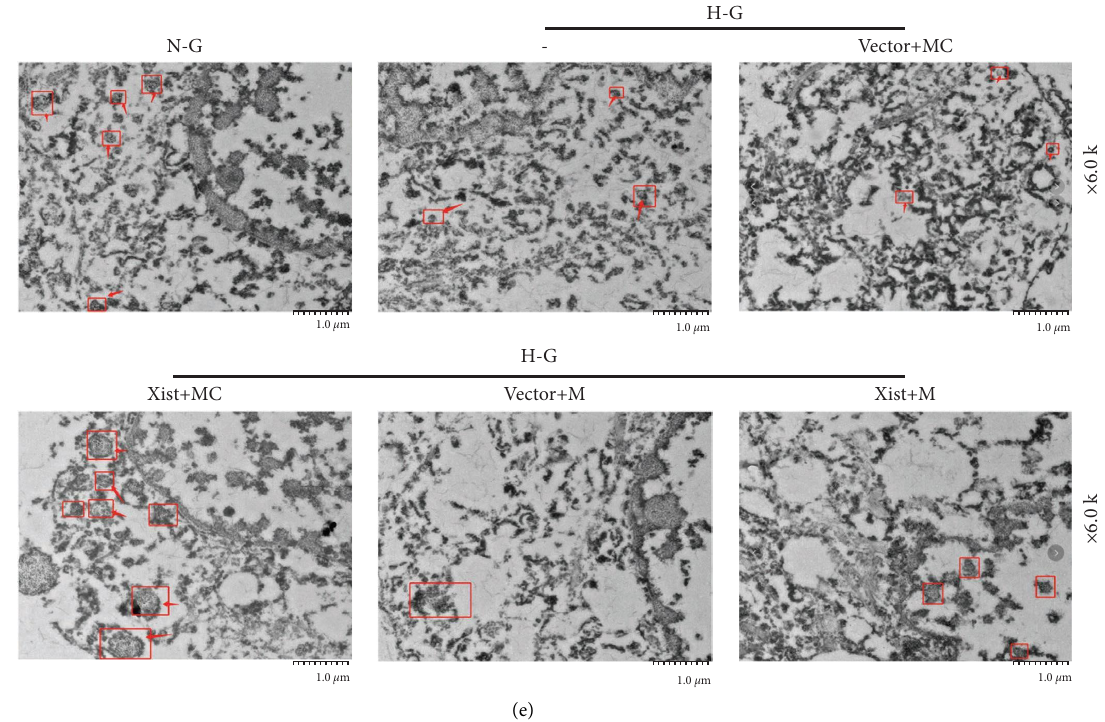
Figure 5: XIST targeted miR-30d-5p to regulate autophagy-related proteins and autophagosomes in HG-induced podocytes. Te ex- periments were divided into six groups. Te frst two groups of MPC5 cells were treated with NG or HG. Te last four groups of MPC5 cells cotransfected with XIST overexpression plasmid/empty vector and miR-30d-5p mimic/mimic control were treated with HG. (a–d) Te expressions of autophagy-related proteins (Beclin-1, LC3I/II, and P 62) in MPC5 cells were determined by Western blot. GAPDH was used as the internal control. (e) Te autophagosomes in MPC5 cells were observed by the transmission electron microscope (magnifcation: 6,000x times; scale bar � 1 μ m). Te quantifed values were presented as mean ± standard deviation of at least three independent exper- iments. ∧ p < 0 . 05, ∧∧∧ p < 0 . 001 vs. vector+MC. # p < 0 . 05, ### p < 0 . 001 vs. XIST +MC. & p < 0 . 001, &&& p < 0 . 001 vs. vector+M. HG: high glucose. NG: normal glucose. M: mimic. MC: mimic control. GAPDH: glyceraldehyde-3-phosphate dehydrogenase; XIST: X inactive specifc